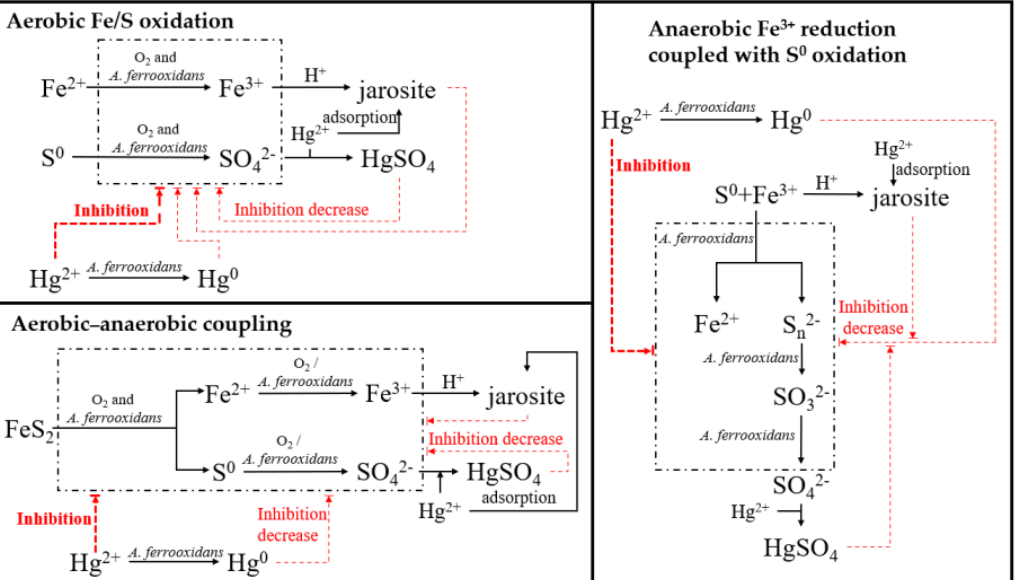
Figure 10. Correlation between the iron/sulfur redox mediated by Acidithiobacillus ferrooxidans ATCC 23270 and the mercury transformation therein. The black dashed boxes indicate the iron/sulfur redox process of A. ferrooxidans ATCC 23270, the black solid lines indicate the formation of the intermediate and/or products, and red dashed lines indicate the inhibition of bacterial activity by mercury.